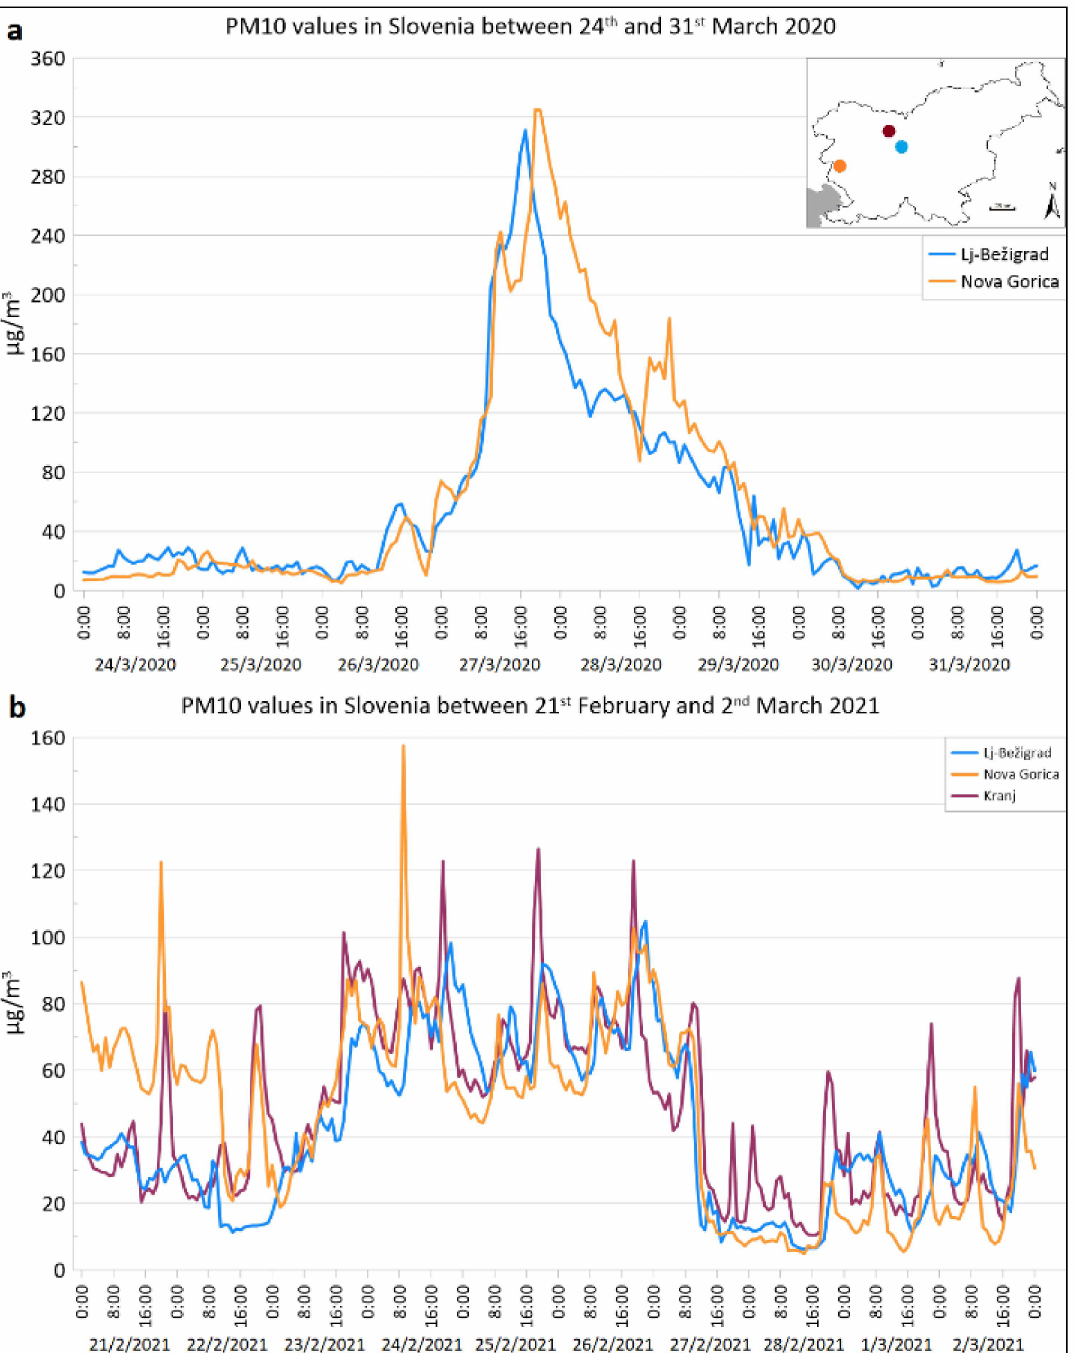
Figure 4. Hourly PM10 values in Slovenia measured in 3 stations (Ljubljana, Nova Gorica and Kranj) during dust event periods in 2020 ( a ) and 2021 ( b ). Data was provided by Slovenian Environment Agency